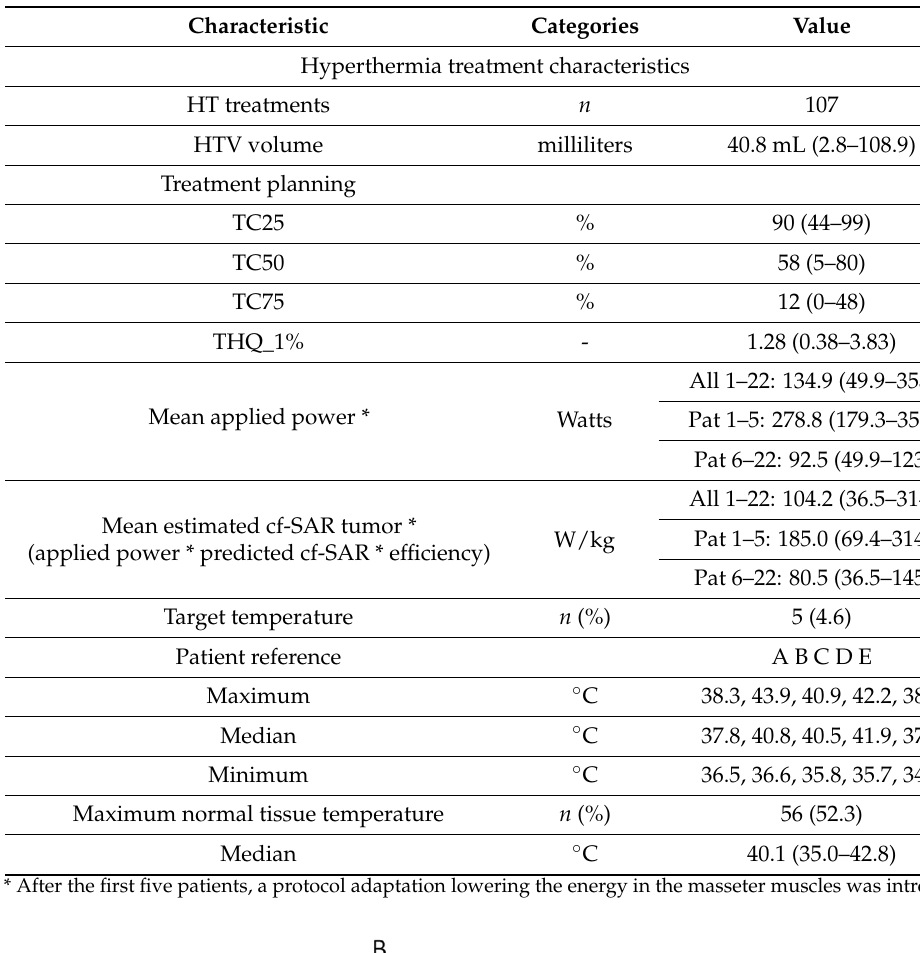
Table 2. Hyperthermia treatment parameters.